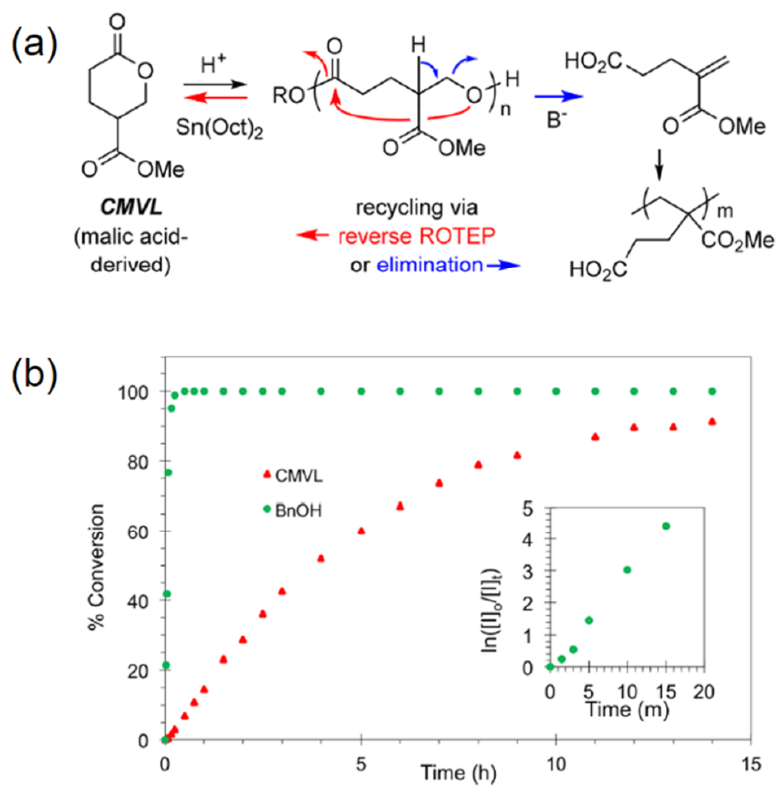
Figure 6. Reversible polymerization in ring-opening polymerization systems. ( a ) Acid-catalyzed ROP of 4-carbomethoxyvalerolactone (CMVL) and the divergent chemical recycling; ( b ) kinetics of the ROP of CMVL in the presence of BnOH as an initiator. Reproduced with permission from [66] .